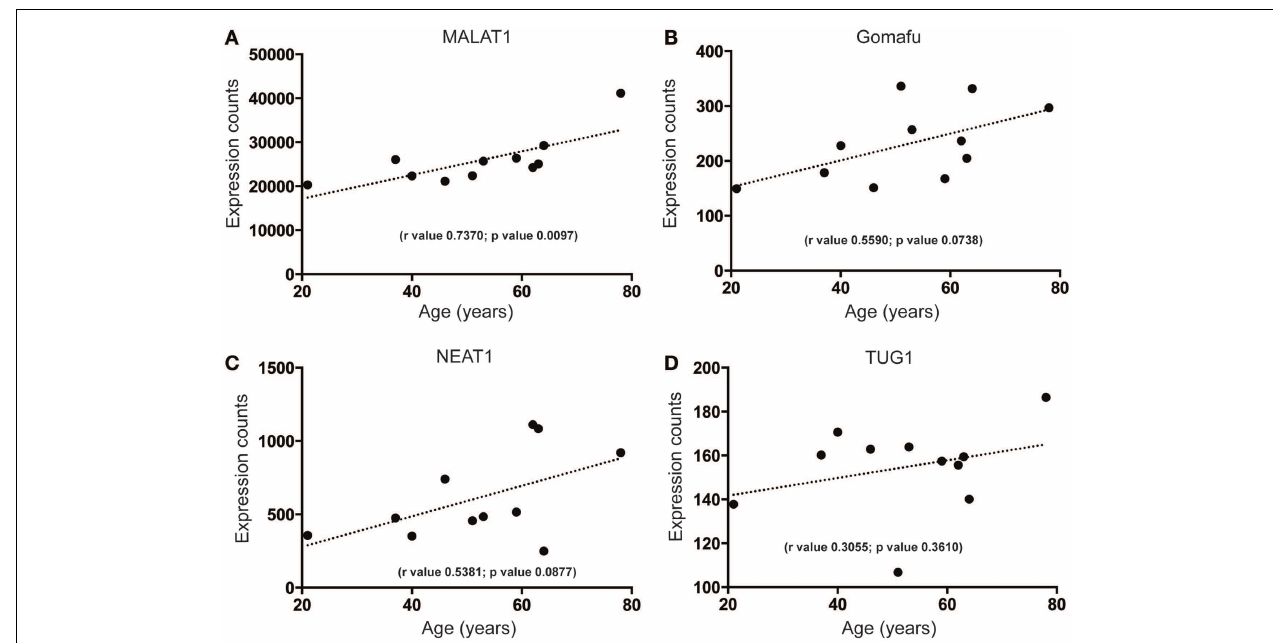
although upward trending, increases in expression during aging are also seen for the highly expressed lncRNAs (B) Gomafu, (C) NEAT1, and (D) TUG1. (Significance is defined as p value < 0.05).